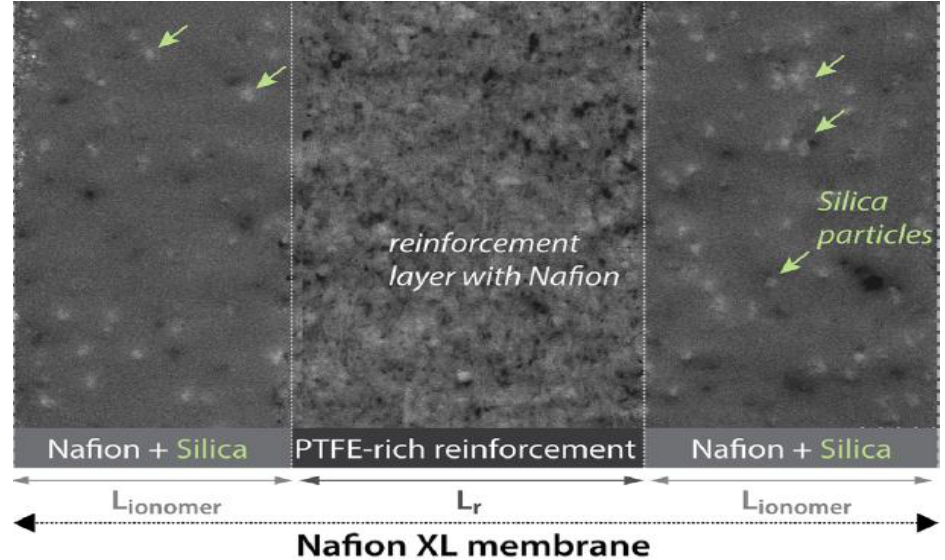
Figure 1. STEM image of the baseline Nafion XL membrane showing the reinforcement layer and additives (Reprinted/adapted with permission from [55] 2022, Asmaa Selim).